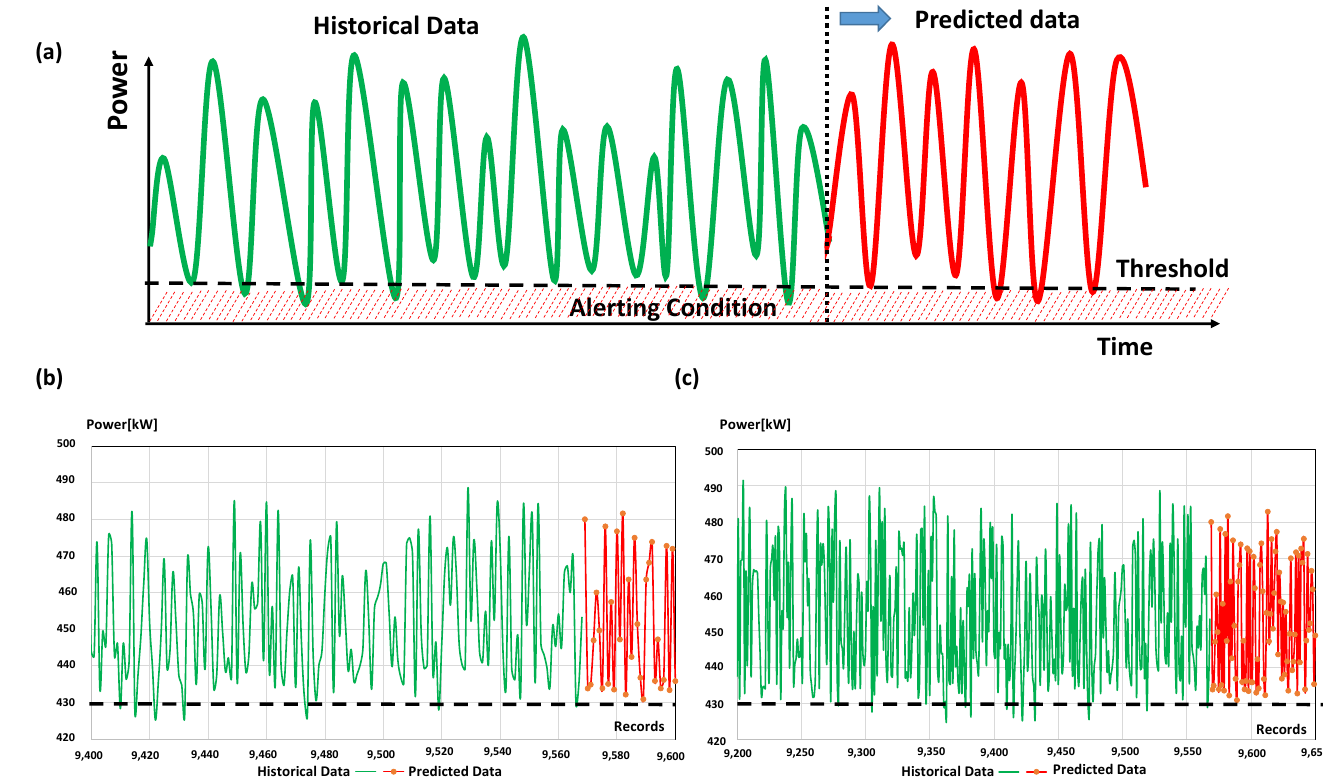
Figure 9. ( a ) Theoretical trend of energy distinguishing historical data (green plot) from predicted ones (red plot): the values under the threshold indicates an alerting condition (risk condition). ( b ) Historical data (green plot) [25] and ANN-MLP results (red plot) in the short period. ( c ) Historical data (green plot) [25] and ANN-MLP results (red plot) in the medium period. According to the indicated threshold, it is observed for the analyzed case a no accentuated risk condition (no alerting about production of energy power).